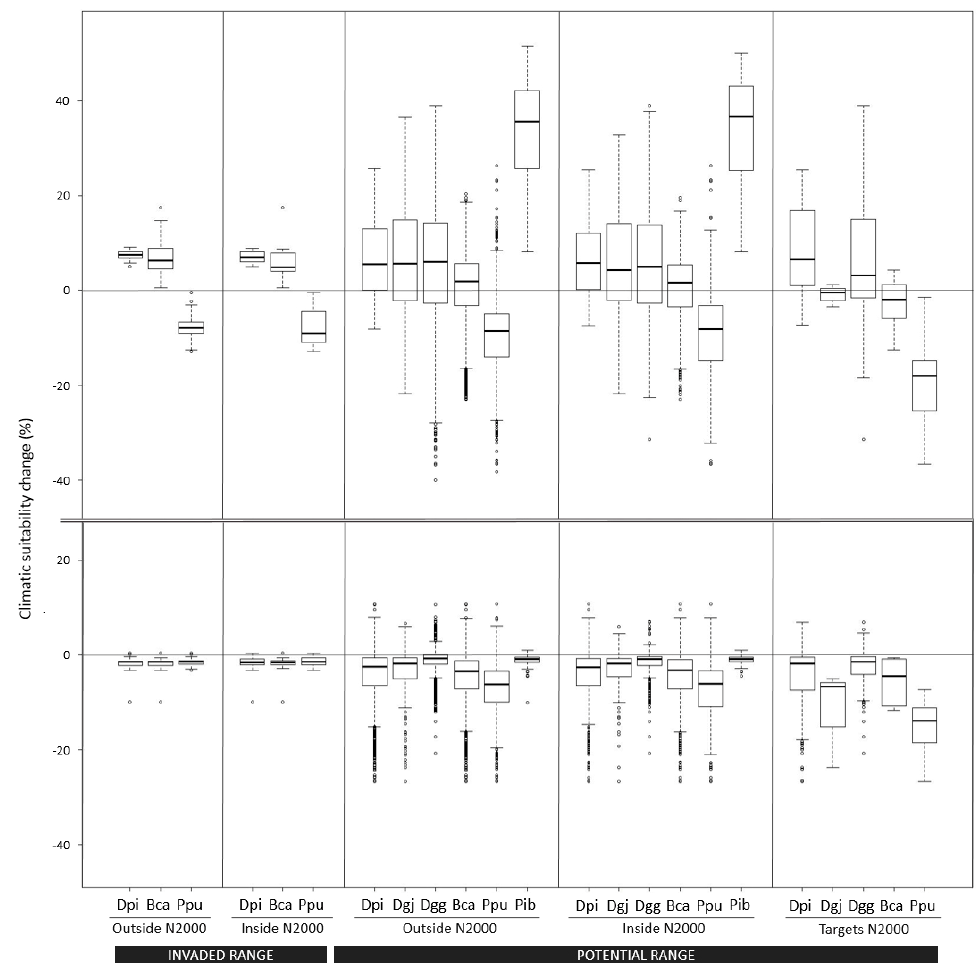
Figure 4. Species climatic suitability change (%) under optimistic ( upper ) and pessimistic ( bottom ) climate warming scenarios, different D. pictus ranges (invaded or potential), and protection regimes, splitting areas inside and outside Natura 2000 (N2000) from those Natura 2000 sites where species are explicitly targeted (Targets N2000). Dpi, Discoglossus pictus ; Dgj, Discoglossus galganoi jeanneae ; Dgg, Discoglossus galganoi galganoi ; Bca, Epidalea calamita ; Ppu, Pelodytes punctatus ; Pib, Pelodytes ibericus . Points show outliers; lower and upper whiskers indicate the 5% and 95% percentiles, respectively; lower and upper hinges indicate the 25% and 75% quartiles, respectively; and the central black line indicates the median value.